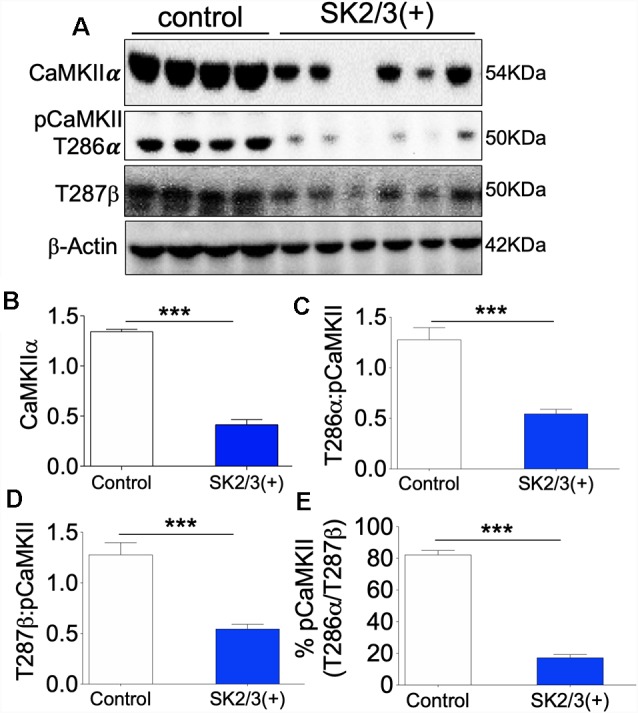
SK channel potentiation reduced hippocampal CaMKII expression (48 h after treatment in vivo). (A) Western blots demonstrating detected level of CaMKII, T286 pCaMKIIα, and T287 pCaMKIIβ in whole hippocampal lysate. (B) Bar graph representing comparative β-actin-normalized CaMKII expression (T-test). (C,D) Bar graph representing comparative CaMKII-normalized T286 pCaMKIIα and T287 pCaMKIIβ expression (T-test). (E) Bar graph demonstrating percentage T286/T287 (total) pCaMKII in the hippocampus (B,C,D,E; ***p < 0.001).